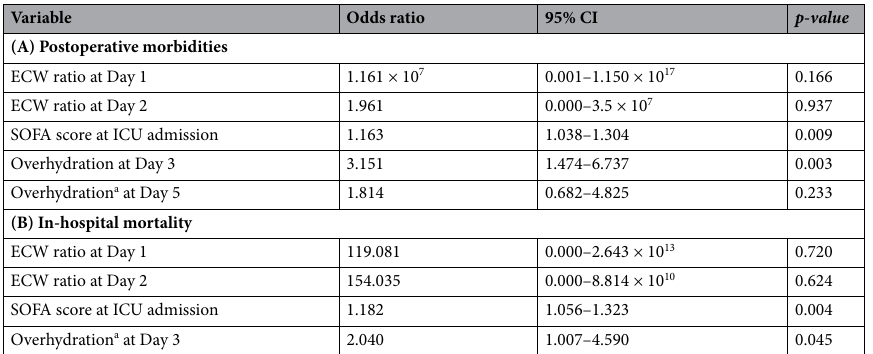
Table 3. Multivariate analyses of independent risk factors for the occurrence of (A) postoperative morbidities and (B) in-hospital mortality. Postoperative morbidities was defined as the occurrence of morbidities as grade III or more according to the Clavien–Dindo classification 12 ; Grade I complication means any deviation from the normal postoperative course without the need of any pharmacologic treatment or interventions, Grade II complications are defined as the cases that require pharmacologic treatment, total parenteral nutrition, or blood transfusion, Grade III complications are any cases that require endoscopic, radiologic, or surgical interventions, Grade IV complications are defined as life-threatening morbidities, Grade V complications represent the death of a patient. a Overhydration is defined as the case where the value of ECW ratio (ECW/ TBW) is above 0.390 13–15